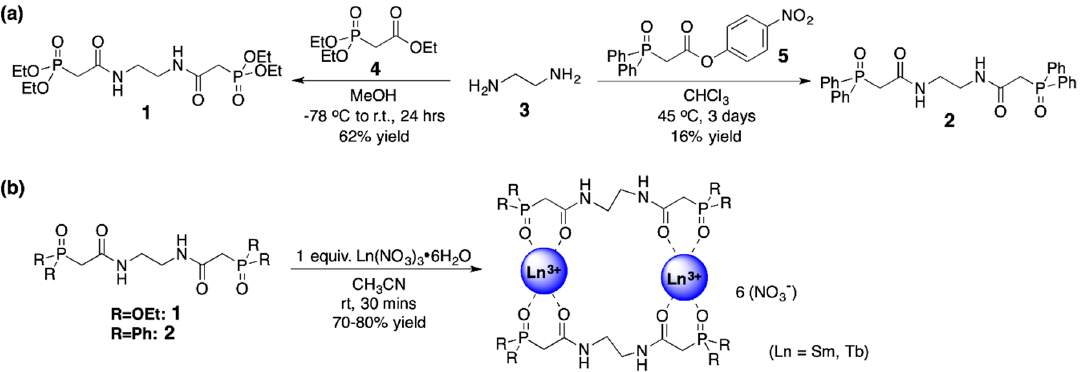
Figure 1. Synthetic pathways to ( a ) ligands 1 and 2 , along with ( b ) their 2:2 Ln ligand complexes. The Ln ligand complex shown in part ( b ) has been simplified for clarity; details regarding the precise coordination environments, including metal-bound nitrate groups and solvent molecules, are described with the X-ray diffraction studies.